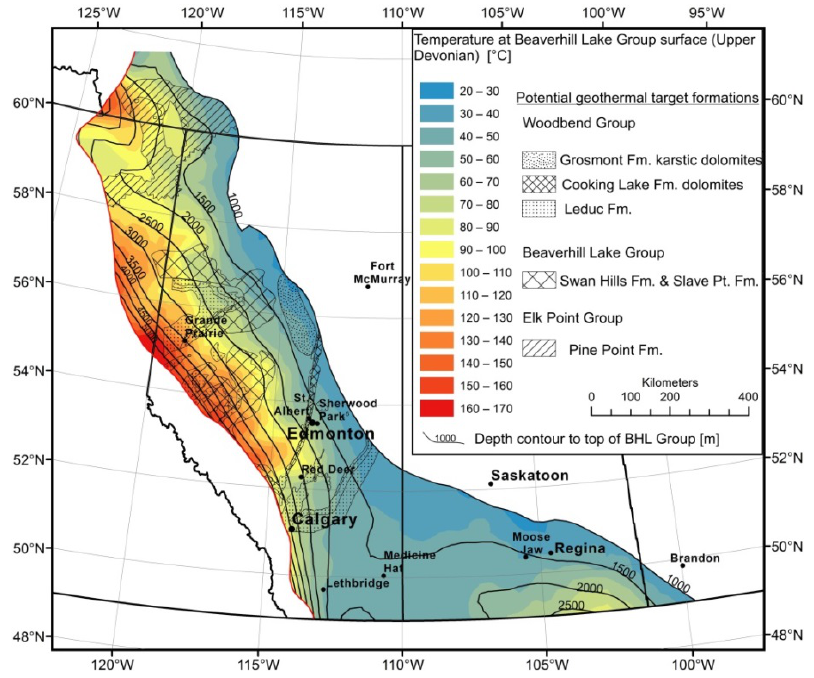
Figure 6. Temperature at the base of Beaverhill Lake Group; formations outline from Switzer et al. [29] (Woodbend Group), from Oldale and Munday [30] (Beaverhill Lake Group) and from Meijer Drees [31] (Elk Point